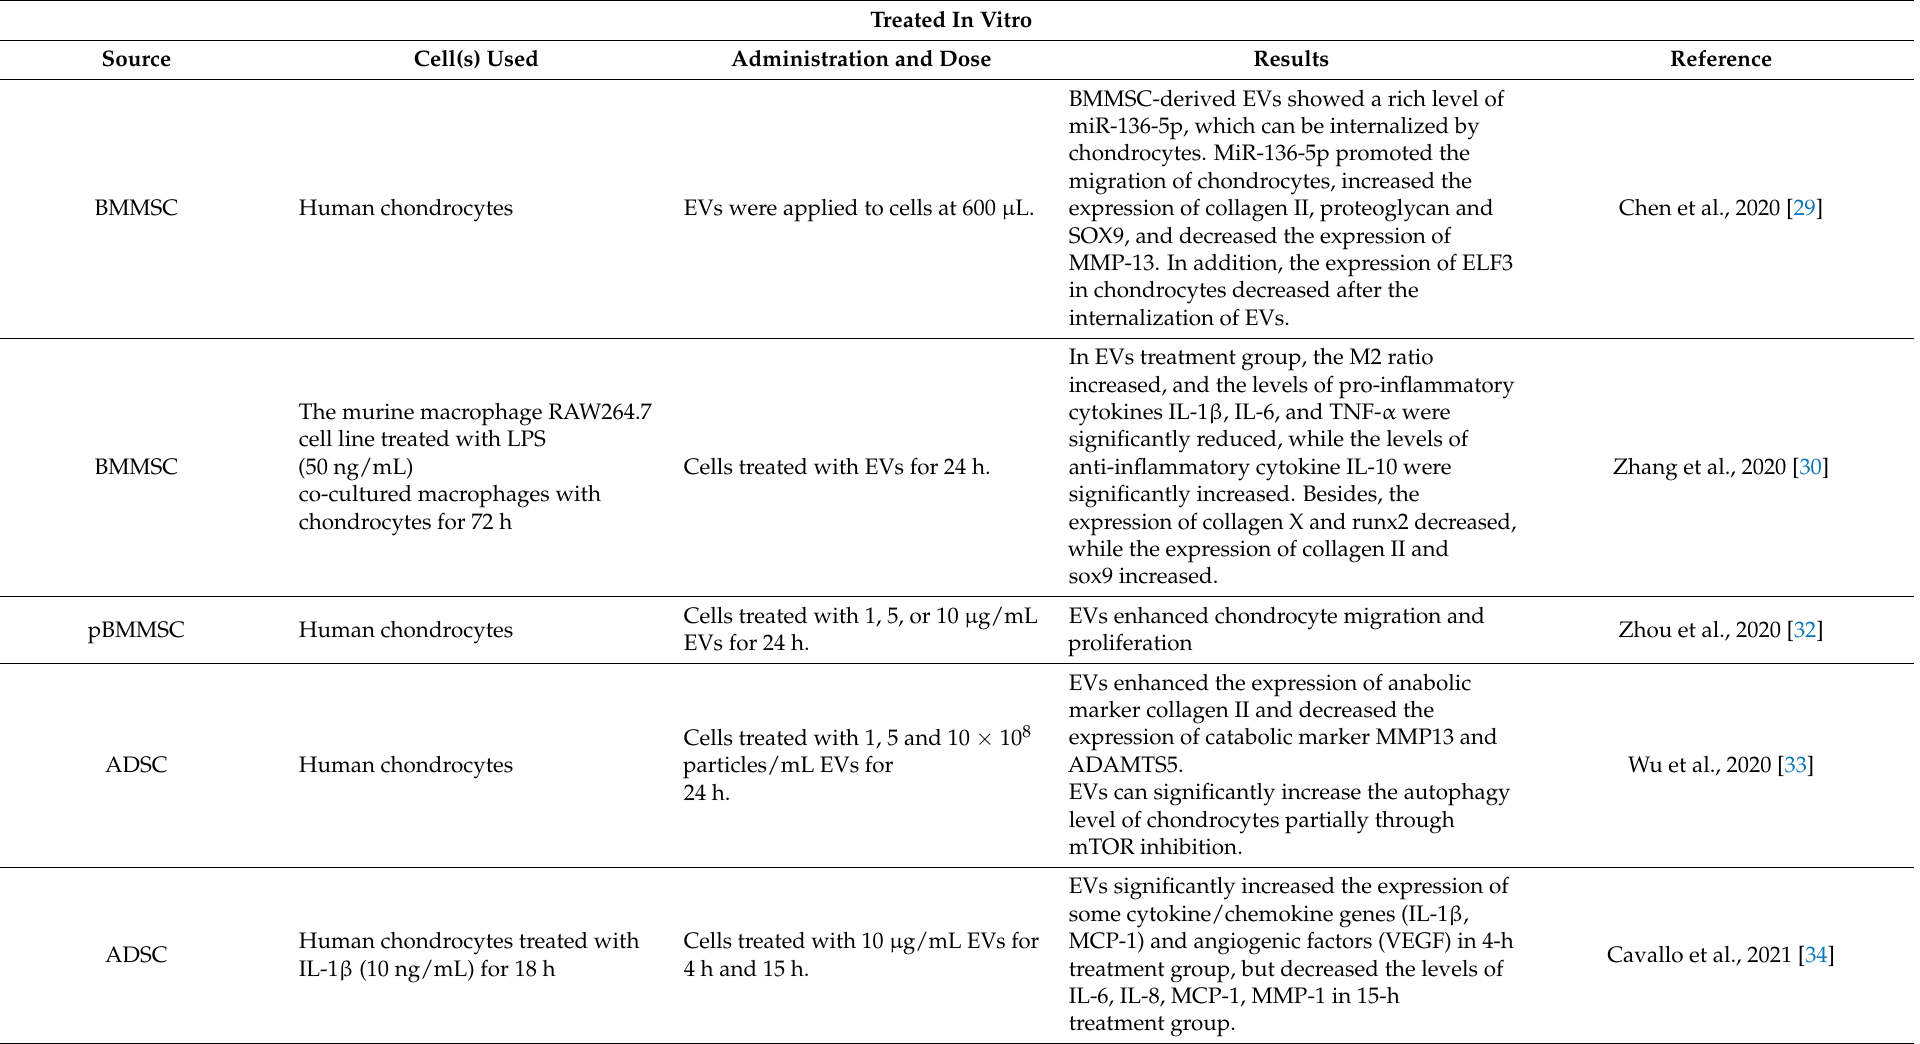
Table 2. Therapeutic applications of EVs in